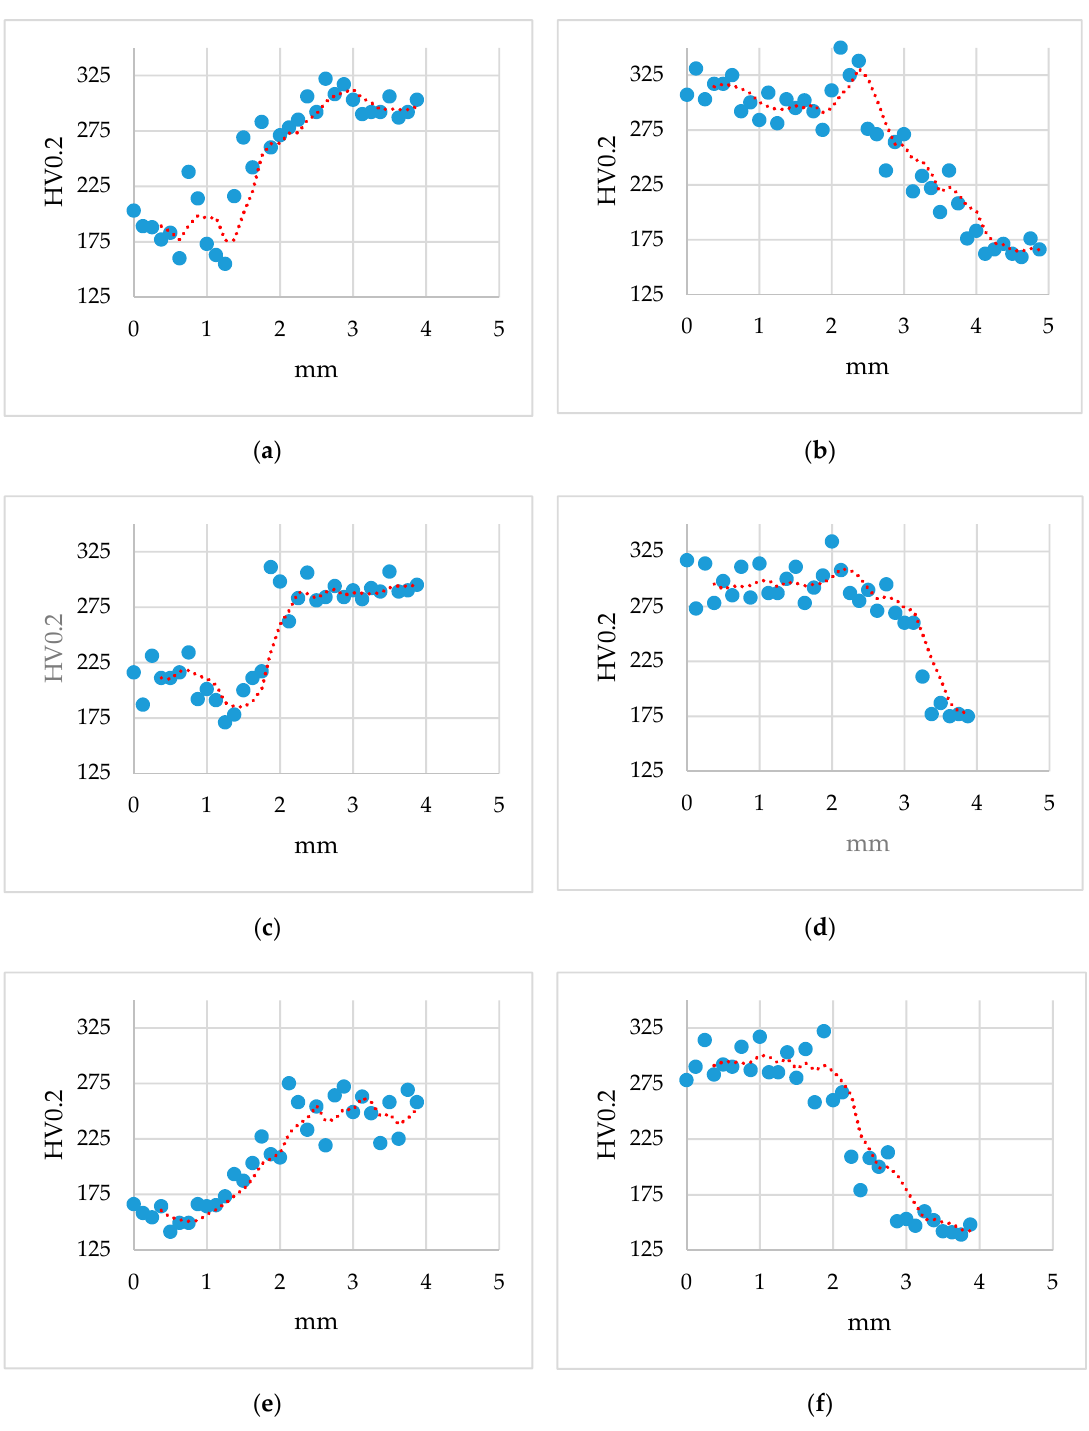
Figure 15. Variation in Vickers hardness values (HV0.2) along the height ( ● is the spot measurement and the red dotted line is the moving average trend line with four measurements as the period) of the graded material deposits. ( a ), ( c ), and ( e ) are the hardness plots on set 1, set 2, and set 3 deposits of 100/0 on 30/70, respectively. ( b ), ( d ), and ( f ) are the are the hardness plots of set 1, set 2, and set 3 depositions of 30/70 on 100/0, respectively.